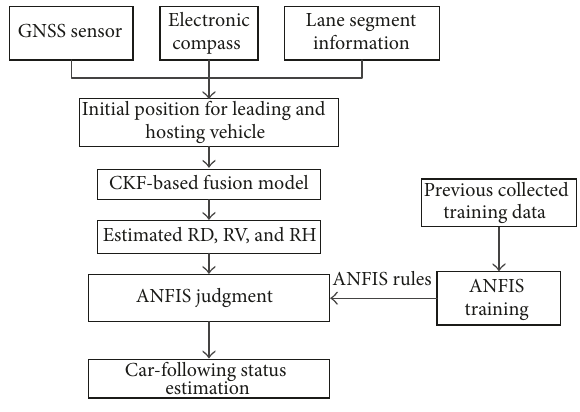
Figure 1: System